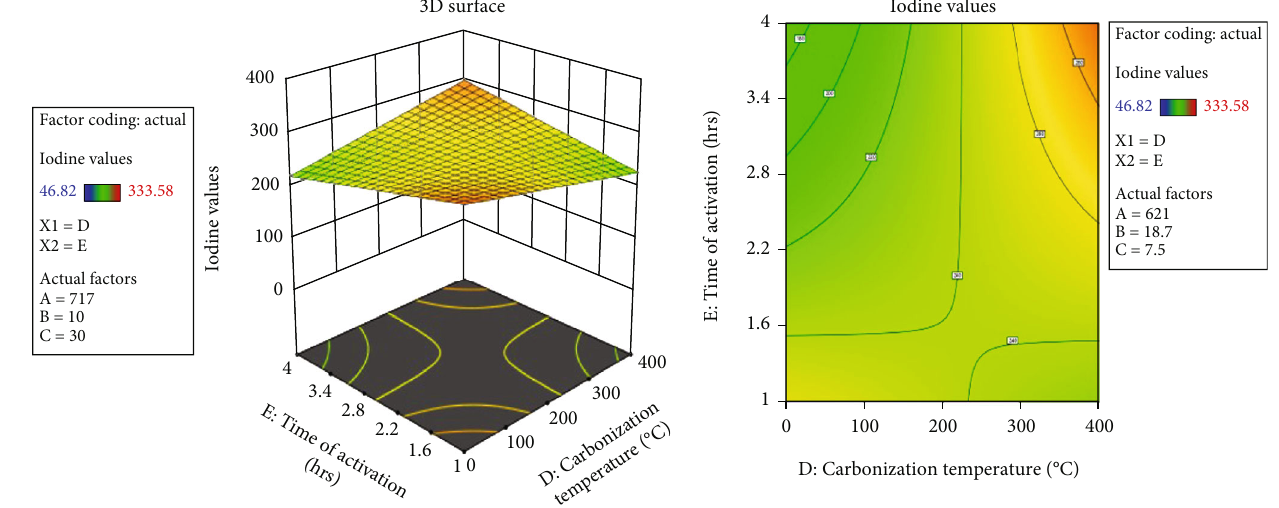
Figure 6: Surface and contour plots of the e ff ect of carbonation temperature based on input